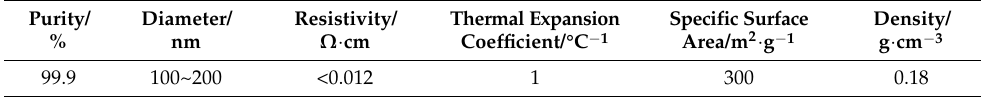
Table 1. Main physical performance index of CNTs.